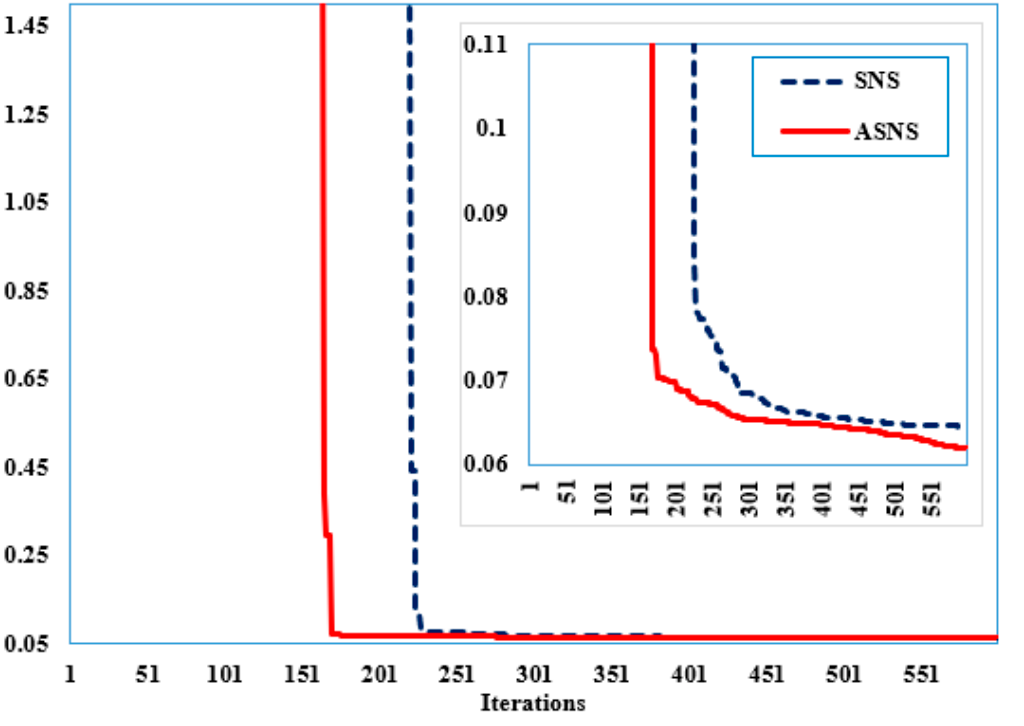
Figure 14. Convergence features of the proposed ASNS and SNS for Case 3 of the IEEE 118-bus grid.